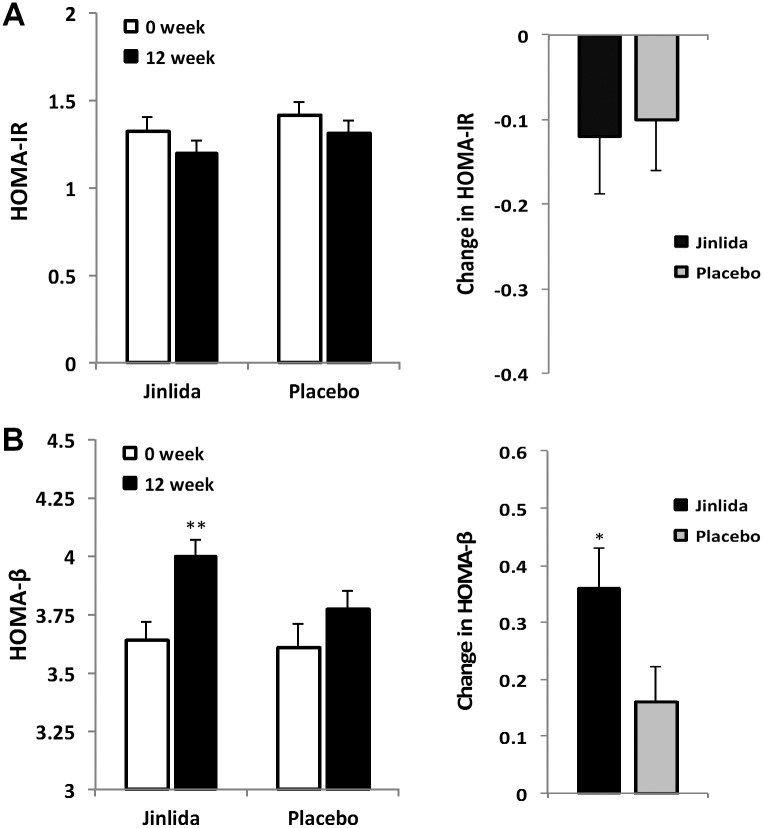
Changes in HOMA-IR and HOMA-β after 12 weeks treatment in the Jinlida group and placebo group.(A) Left: The mean HOMA-IR decreased somewhat in both groups between the baseline and after treatment. Right: Changes in HOMA-IR of the two groups. (B) Left: The mean HOMA-β increased very signigicantly in the Jinlida group between the baseline and after treatment. Right: There was a significant statistical difference in the change between the two groups. Data presented as mean ± S.E. * p < 0.05. **p < 0.01.